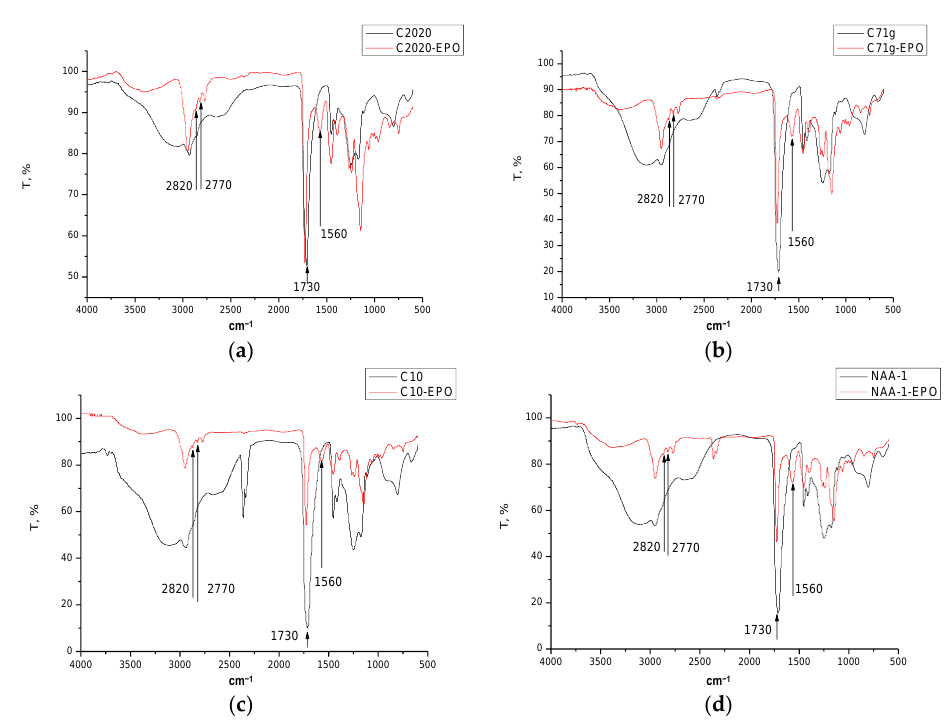
Figure 1. ATR-FTIR-spectra of C2020 and IPEC C2020/EPO ( a ); C71G and IPEC C71G/EPO ( b ); C10 and IPEC C10/EPO ( c ); and NAA-1 and IPEC NAA-1/EPO ( d ). Table 3. MDSC data on raw materials and placebo IPECs.